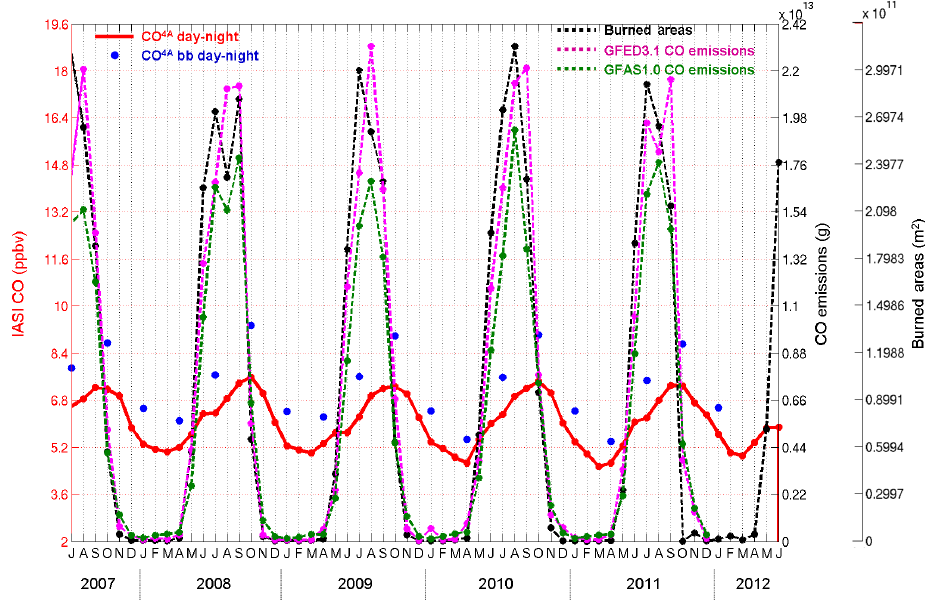
Figure 11. Evolution of the day–night difference of the integrated content q CO 4A (see text Sect. 4.1) on land, and of fires, between July 2007 and June 2012 in southern Africa. Red: day–night difference of q CO 4A . Blue dots: day–night difference of q CO 4A computed with a polluted CO profile as input in 4A. Black dashed: MODIS burned areas. Purple dashed: CO emissions from GFED3.1. Green dashed: CO emissions from GFAS1.0.